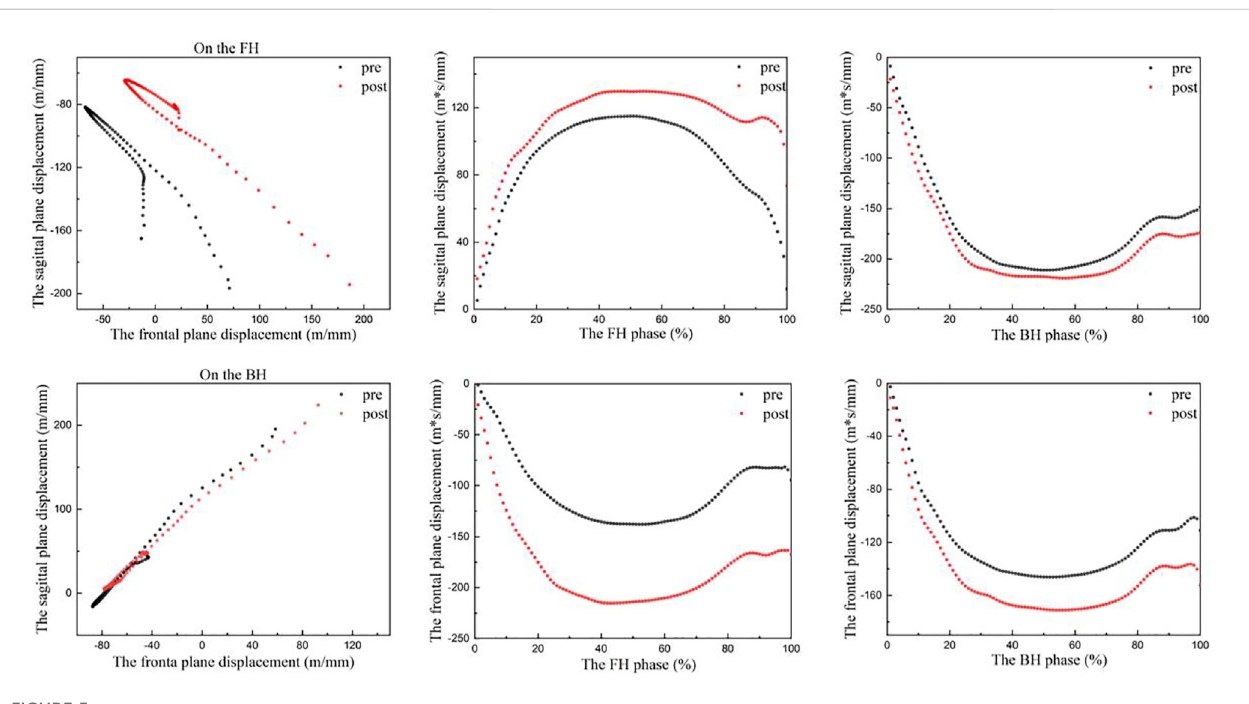
FIGURE 5 Change in the center of pressure in the FH and BH during the strike phase. FH, forehand lunge; BH, backhand lunge; pre, pre-fatigue, post,